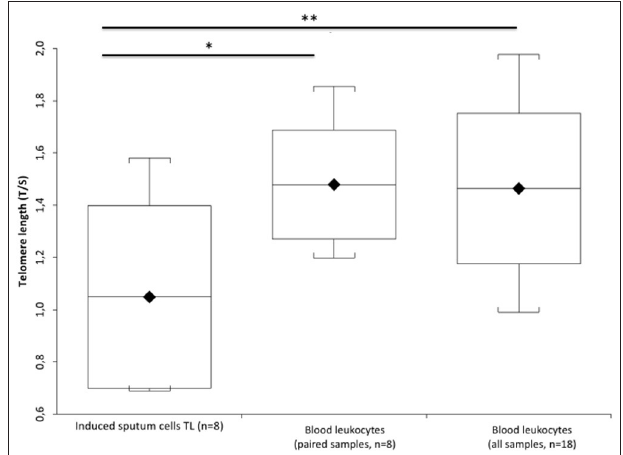
FIGURE 2 | TL of the induced sputum cells and blood leukocytes in COPD patients. Box plots show levels of TL in induced sputum cells ( n = 8) and in paired blood leukocytes of the same patient ( n = 8), and blood leukocyte samples of all patients ( n = 18). In box plots, the boundary of the box closest to the x-axis indicates the 25th percentile, the line within the box marks the mean, and the boundary of the box farthest from the x-axis indicates the 75th percentile. Whiskers (error bars) above and below the box indicate the 95 and 5th percentiles. The horizontal bar with one asterisk indicates the significant comparison between induced sputum cells ( n = 8) and paired blood leukocyte TL of the same patient ( n = 8) (*Paired t -test: mean 1.05 ± 0.35 T/S vs. mean 1.48 ± 0.21 T/S; p = 0.0341). The upper longer horizontal bar with two asterisks indicates the significant comparison between TL of the induced sputum cells ( n = 8) and blood leukocytes in all patients ( n = 18) (**MannWhitney U -test: mean 1.05 ± 0.35 T/S vs. mean 1.47 ± 0.26 T/S; p =